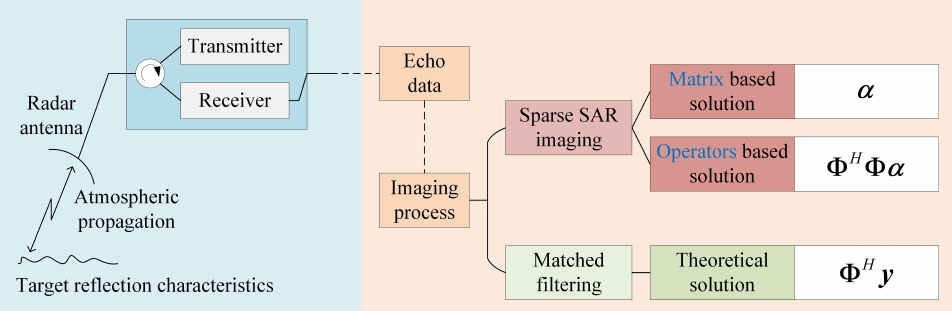
Figure 3. Various factors affecting SAR imaging